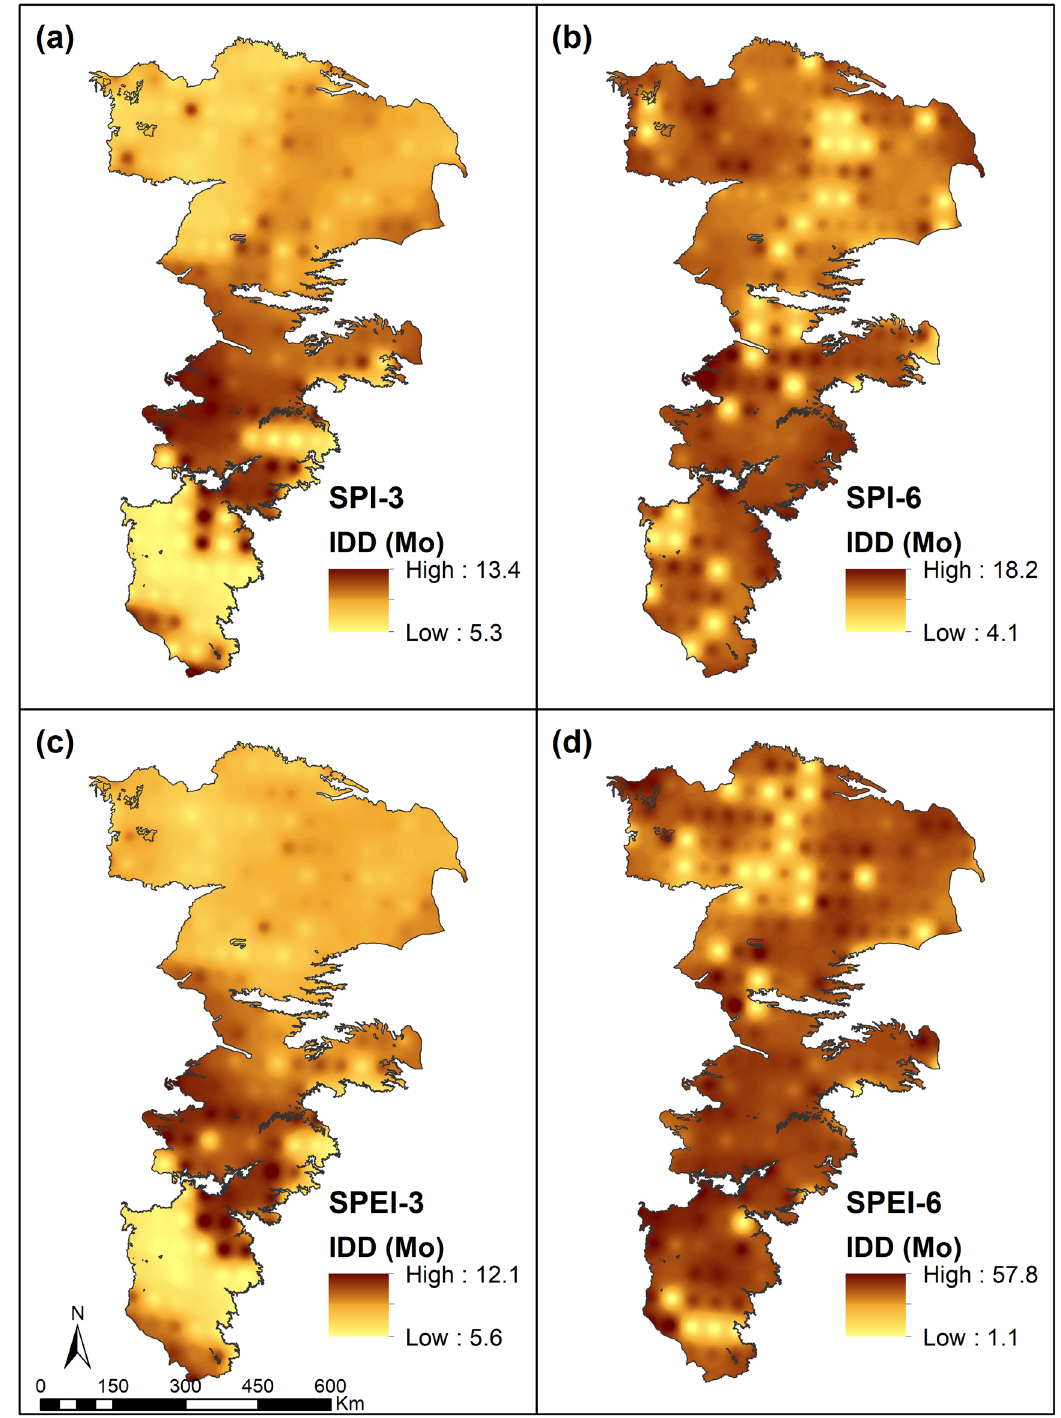
Figure 6. Expected value of inter-drought duration (IDD) of SPI and SPEI at 3- and 6-month